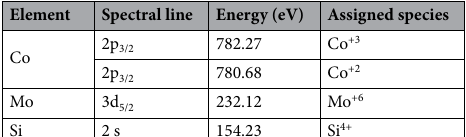
Table 2. XPS binding energies and assigned species for Co 2p, Mo 3d and Si 2 s.